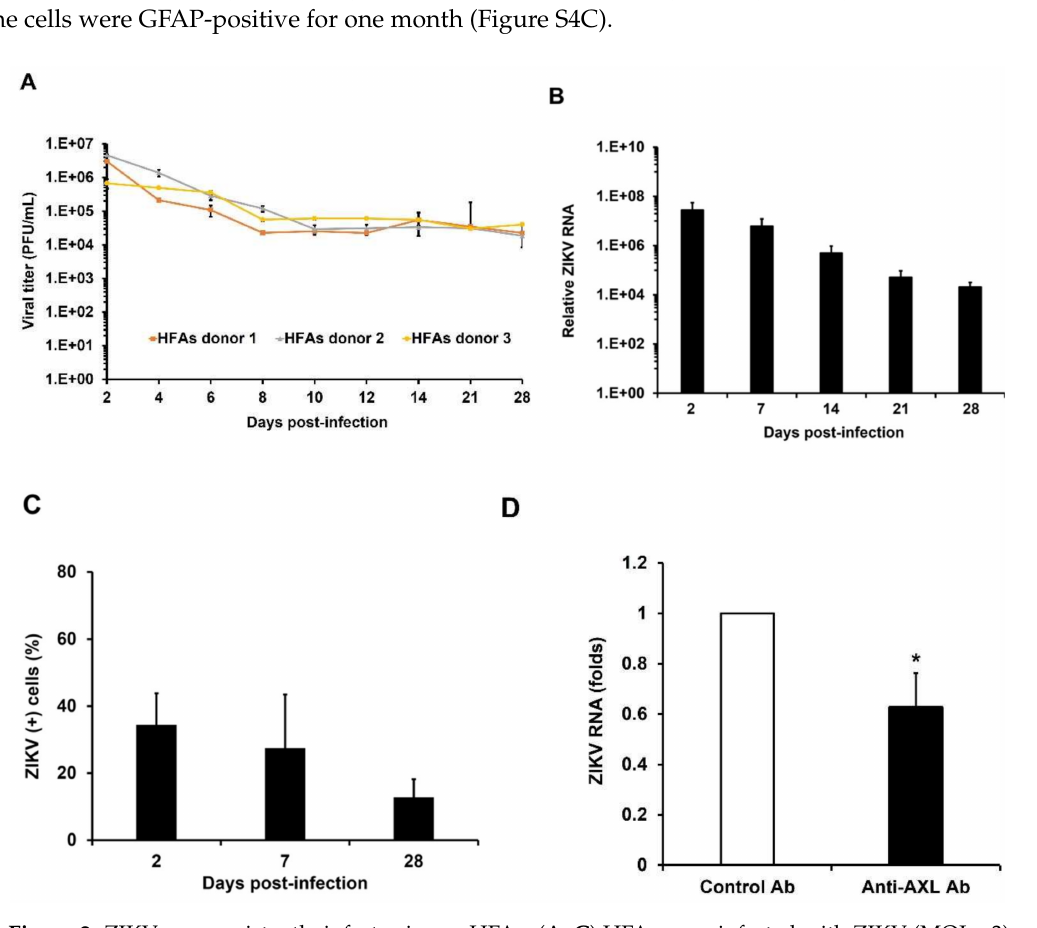
Figure 2. ZIKV can persistently infect primary HFAs. ( A – C ) HFAs were infected with ZIKV (MOI = 3) and media were collected at the indicated intervals for up to 28 days. Viral titers were determined by plaque assay. The percentages of infected cells at indicated time periods were determined by indirect immunofluorescence using antibodies against flavivirus envelope protein. ( A ) ZIKV titers in persistently infected HFAs. The average titers obtained from two experiments using three independent donors are shown. ( B ) Measurement of viral replication by qRT-PCR. The average values obtained from two experiments using two independent donors are shown. ( C ) Percentage of infected HFAs over time is shown. ( D ) Importance of viral spread in maintaining chronic infection. HFAs infected with ZIKV for 14 days were treated with anti-AXL (4 µ g/mL) for 4 days and viral replication was determined by qRT-PCR. The average values obtained from three experiments using two independent donors are shown. Error bars represent standard error of the mean. * p < 0.05 (Student’s t